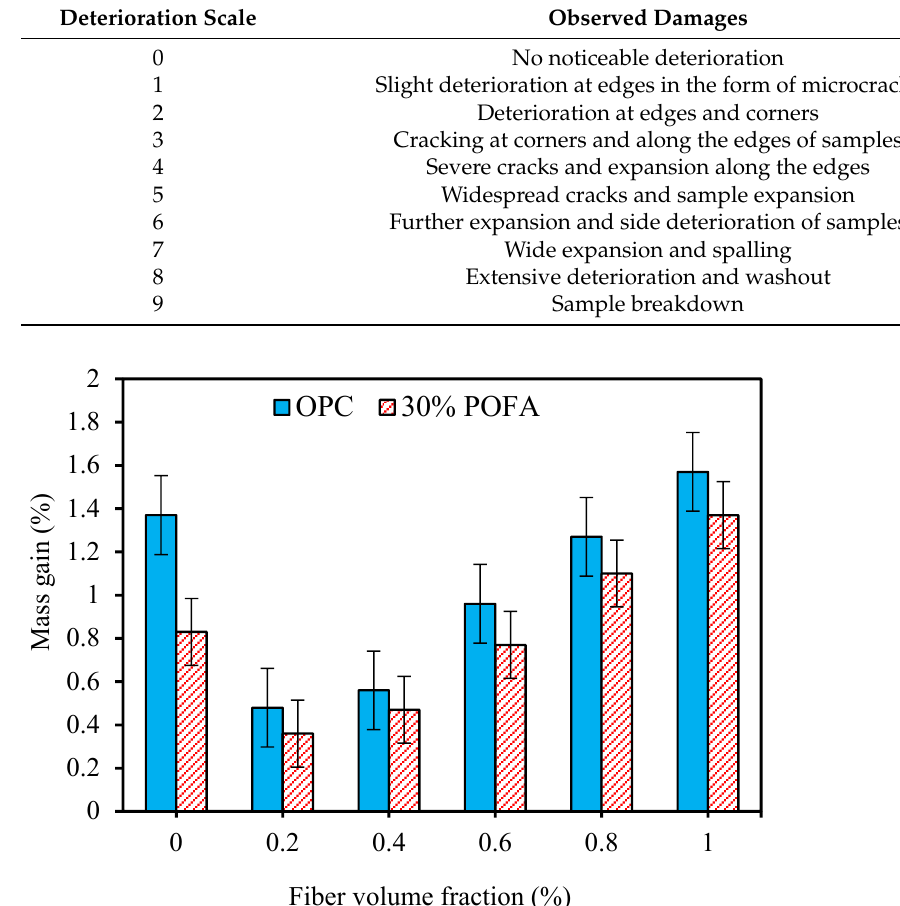
Table 4. Assumed degree of deterioration and the detected damages.